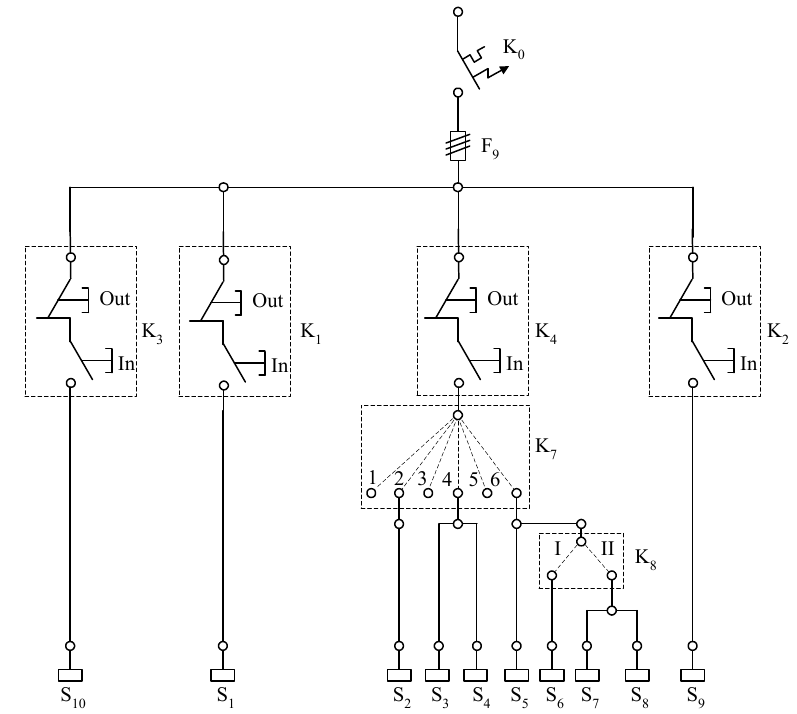
Figure 11. Wiring diagram of the switch cabinet and control panel (diagram 2).